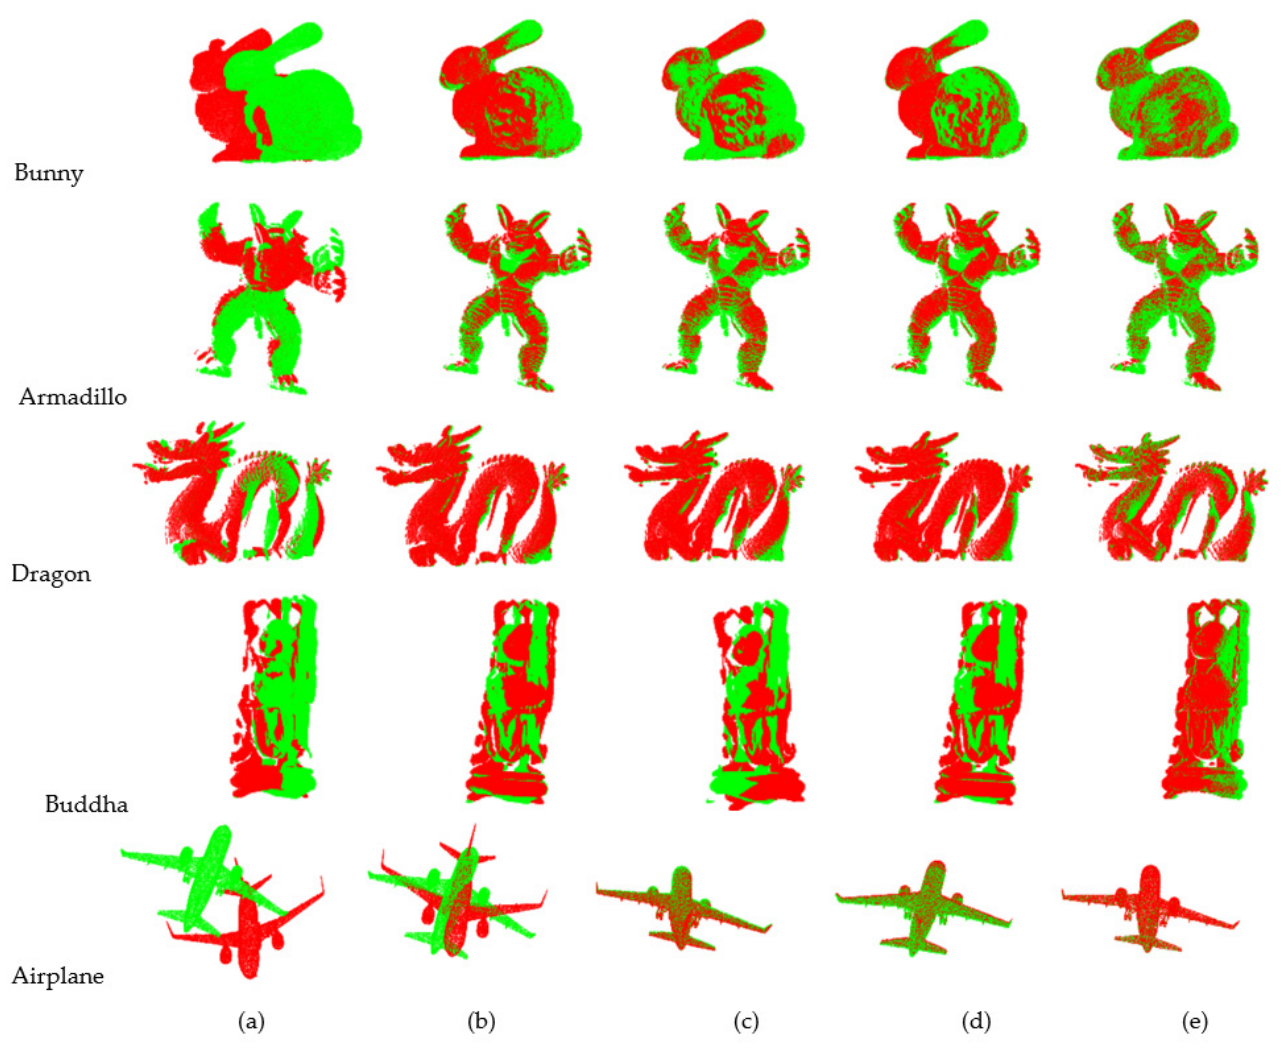
Figure 7. Registration effect of different angles.( a )Initial position; ( b )ICP; ( c ) Ref. [27]; ( d ) Ref. [28]; ( e ) Proposed. Table 5. Comparison of numbers in each processing stage.